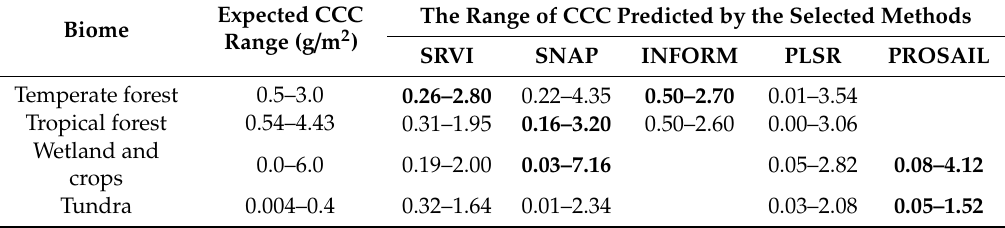
Table 5. Expected CCC range in each biome obtained from previous studies [10,60–63] and CCC ranges predicted by the candidate algorithms. Cells in bold show predicted CCC ranges by candidate methods nearer to